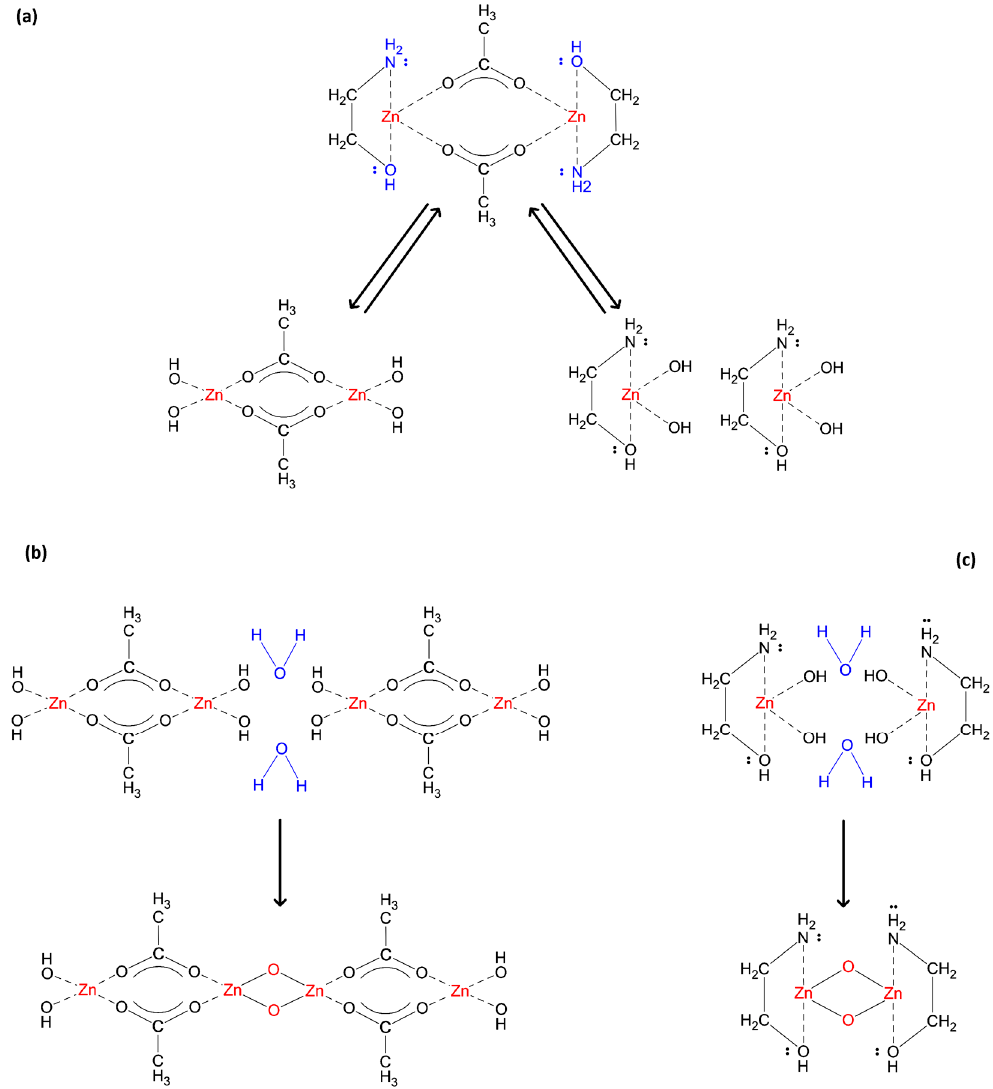
Figure 9. Suggested mechanism for possible hydrolysis ( a ); and condensation reactions ( b ) and ( c ).